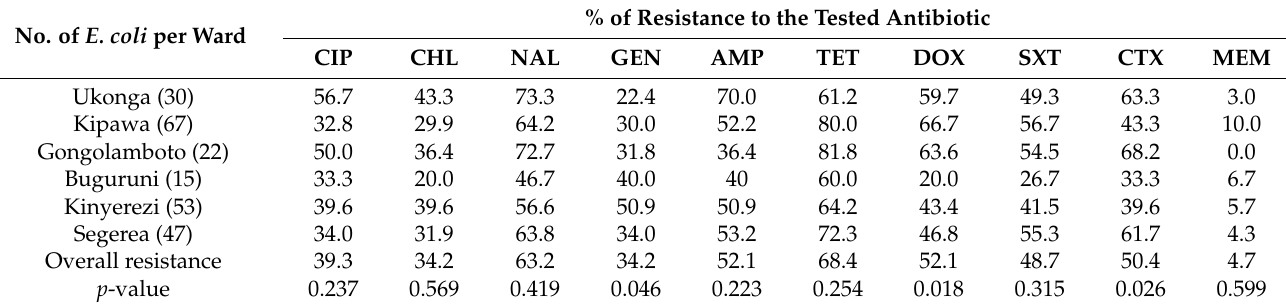
Table 3. Prevalence of antibiotic-resistant E. coli from poultry by ward.